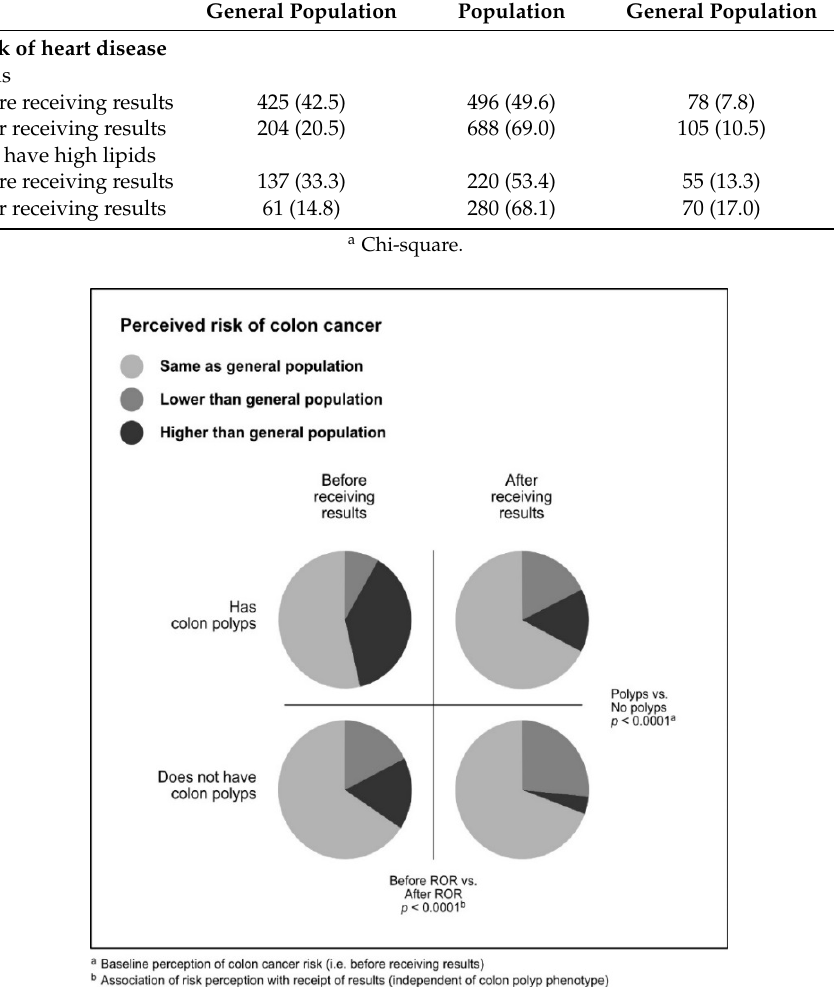
Figure 1. A comparison of perceived risk of colon cancer in patients before and after receiving negative genomic screening results.